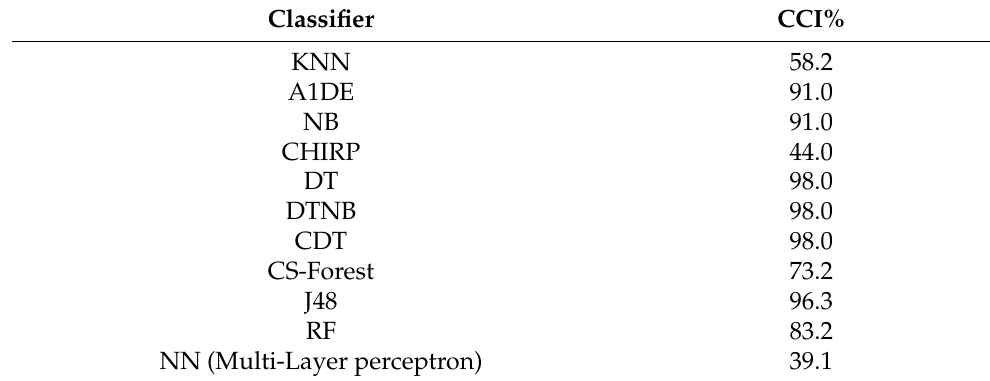
Table 2. Pre-selection comparison of